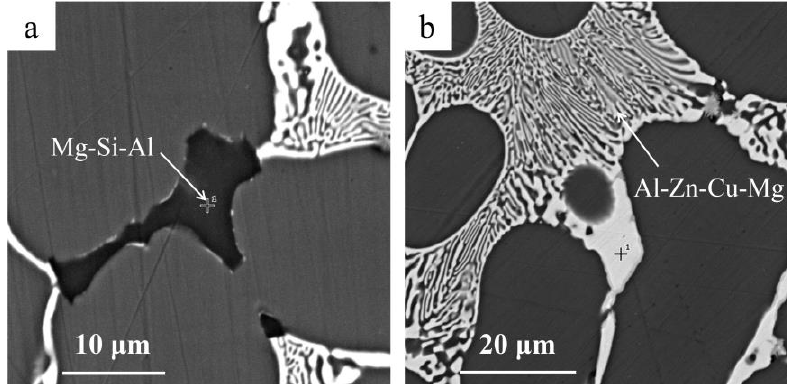
Figure 7. Partial enlarged views of layer 1 in trial 4 under back scattering mode. ( a ) Mg-Si-Al phase; ( b ) Al-Zn-Cu-Mg phase.